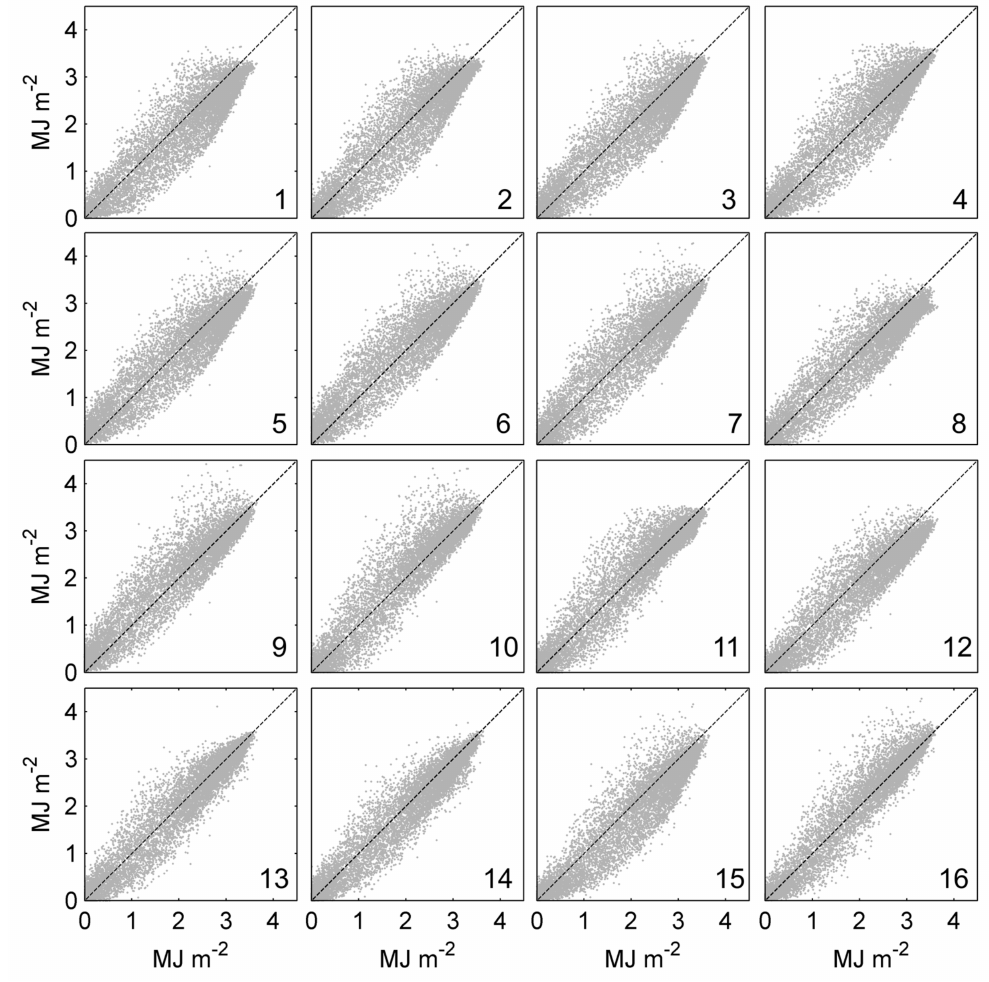
Figure 5. As in Figure 4, but for direct normal irradiation (DNI) observations and